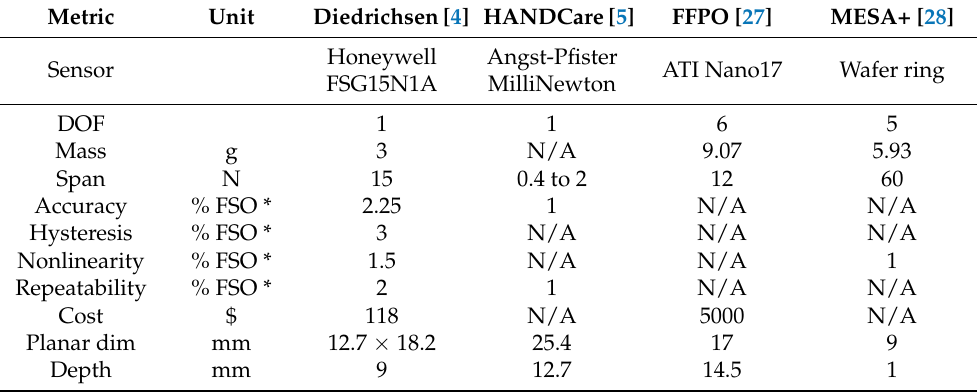
Table 1. Tabular summary of a selection of sensors used in upper-limb